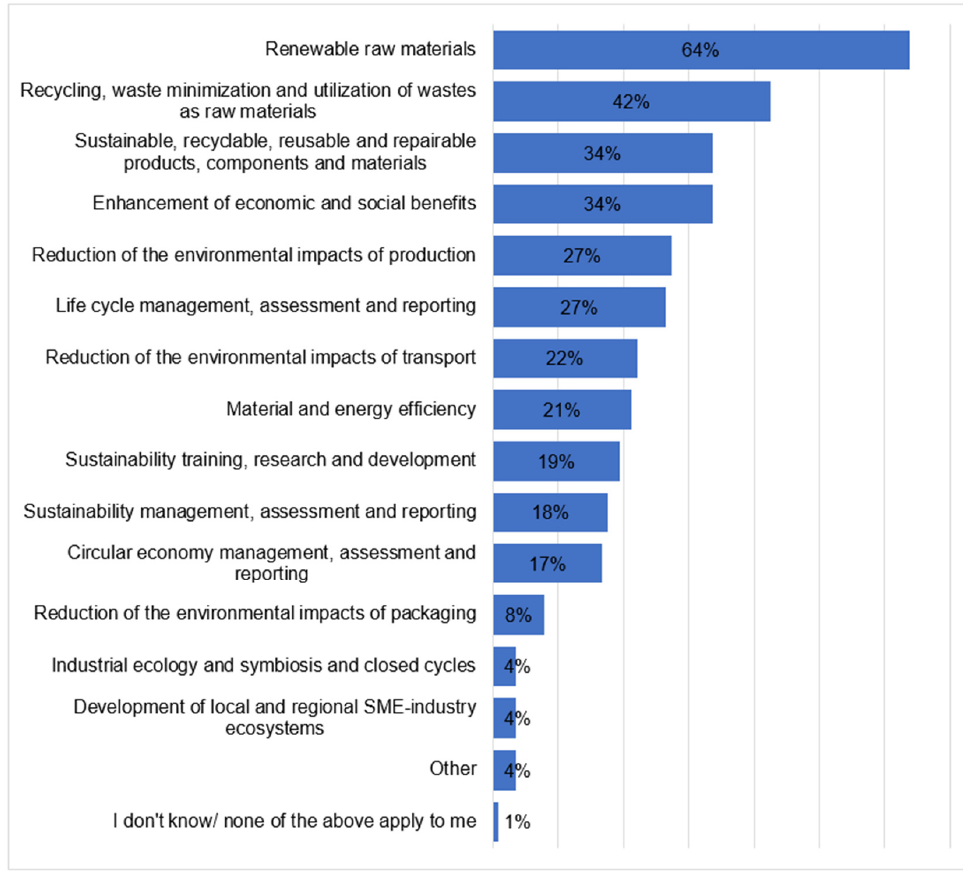
Figure 7. The best approaches to promote sustainable production.